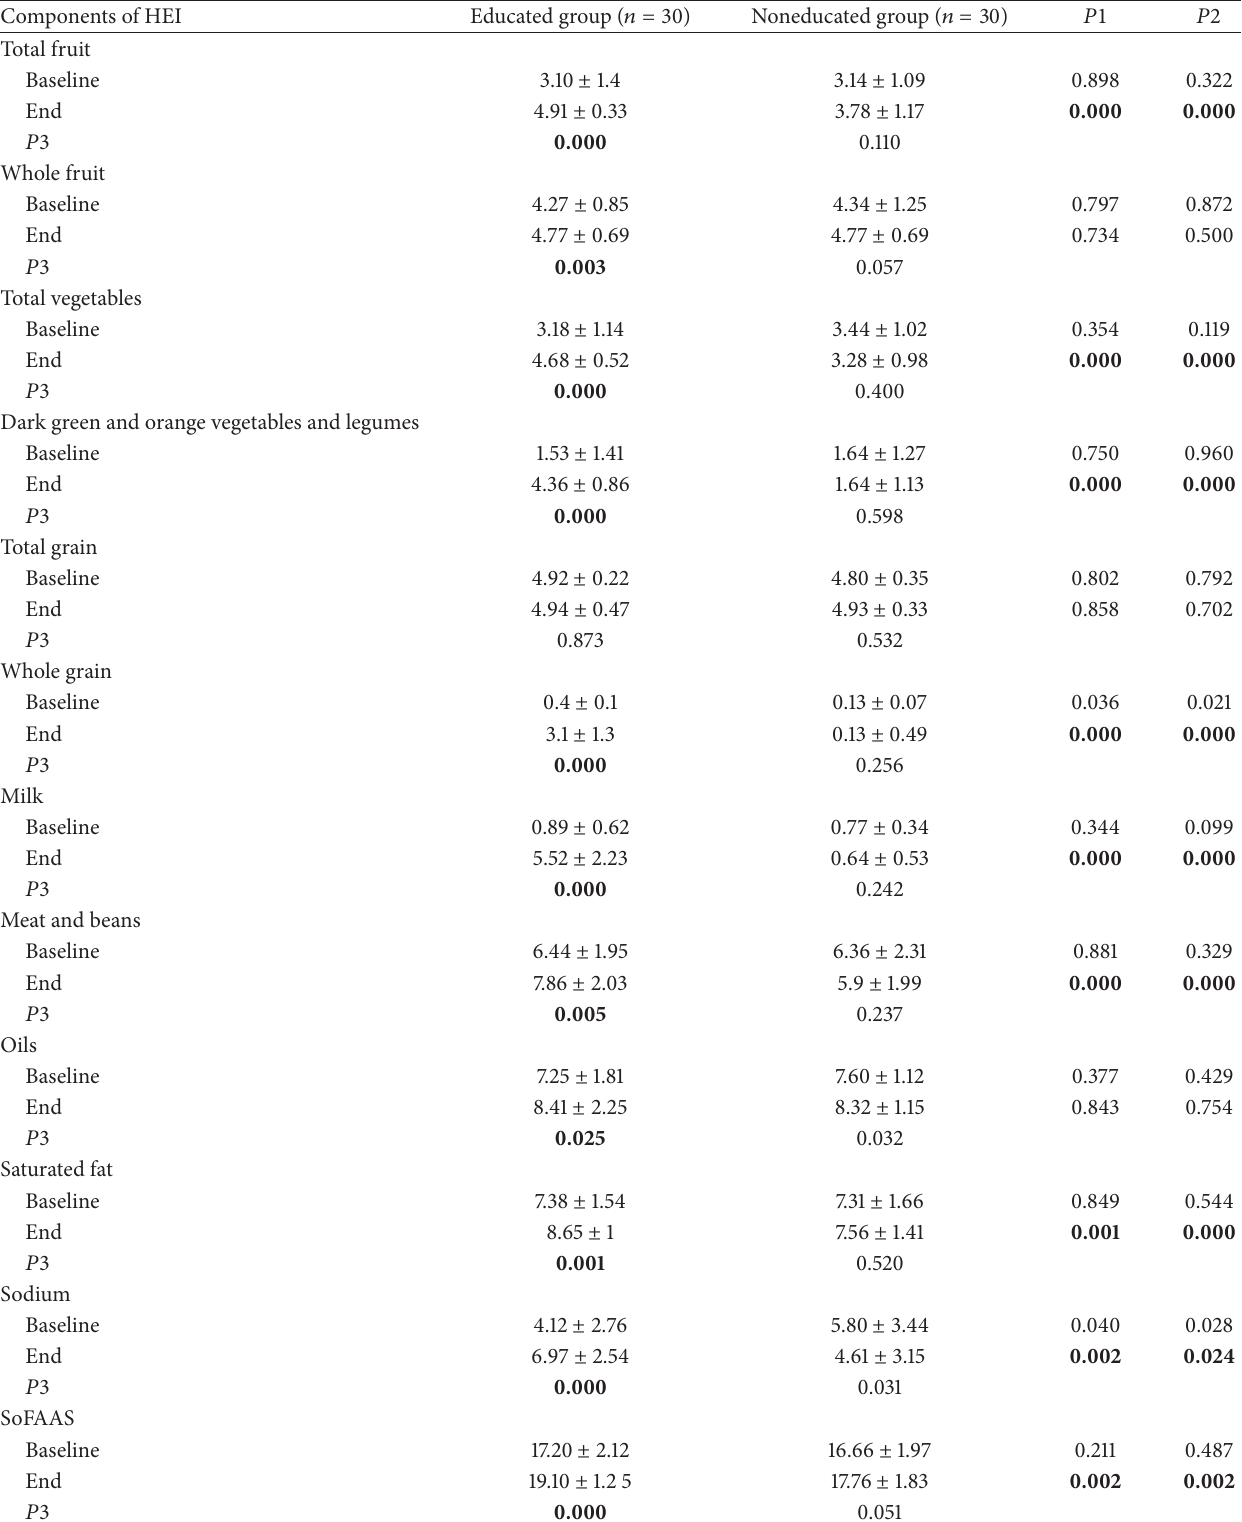
Table 3: Component score of HEI in the study groups at the baseline and end of